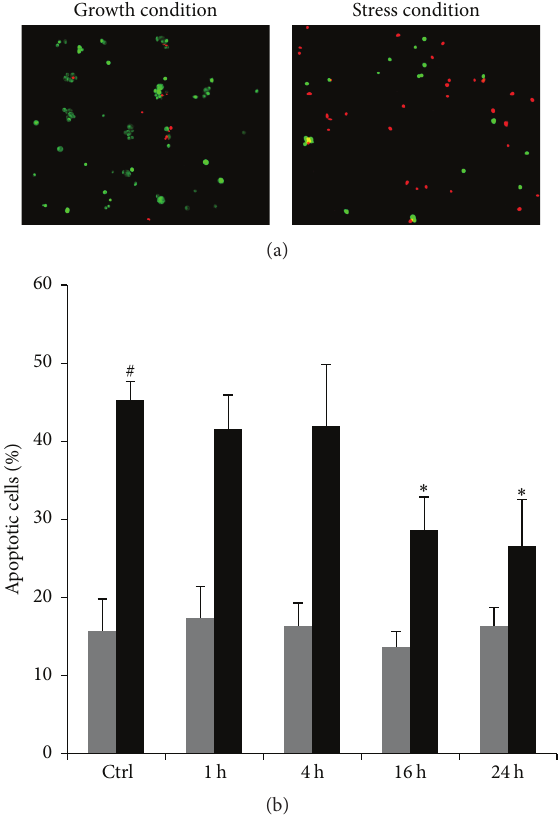
Figure 7: Effect of TAT-Bcp1 on cell apoptosis. Cell apoptosis was evaluated using EB and AO staining. H9c2 cells were treated with TAT-Bcp1 (10 𝜇 M) for different times (1h, 4 h, 16 h, and 24 h) and then subjected to oxidative stress with 0.3 mM H 2 O 2 for 1h. (a) Representative images of the control cells (untreated with TAT-Bcp1) under growth and stress conditions showing both apoptotic (red) and live (green) cells. (b) The graph shows the mean percentages ± SD. of apoptotic cells. The grey and black bars represent the unstressed and stressed cells, respectively. # 𝑝 ≪ 0.01 versus the Ctrl growth condition; ∗ 𝑝 ≪ 0.001 versus the Ctrl stress condition.